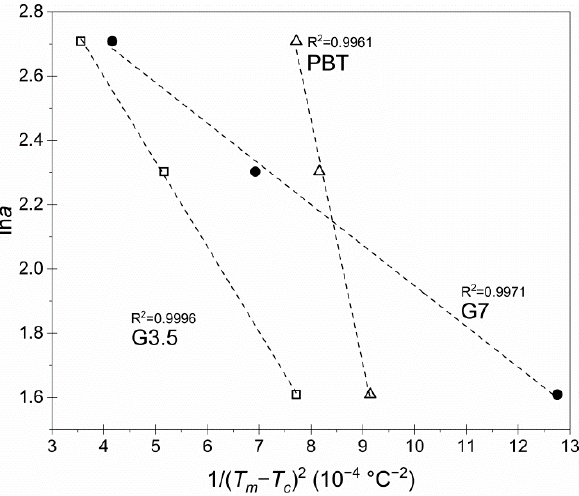
Figure 7. Plots of lna versus 1/ ∆ T c 2 for the neat PBT, G3.5 and G7 vitrimers at the optimum SSP Figure 7. Plots of (cid:1864)(cid:1866)(cid:1853) versus 1/Δ(cid:2002) (cid:3030)(cid:2870) for the neat PBT, G3.5 and G7 vitrimers at the optimum SSP conditions (3 h at 180 °C). conditions (3 h at 180 ◦